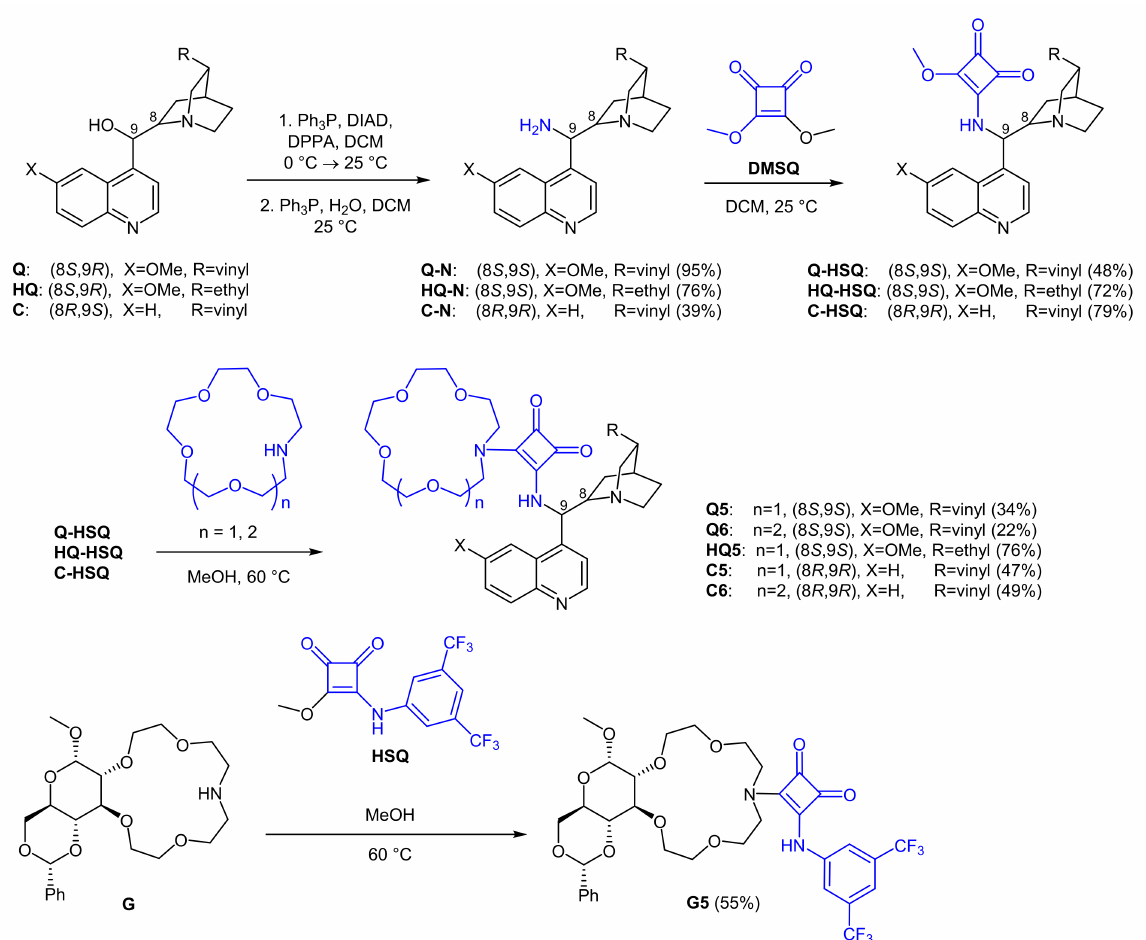
phase-transfer catalysts. DIAD: diisopropyl azodicarboxylate, DPPA: diphenylphosphoryl azide, DCM: